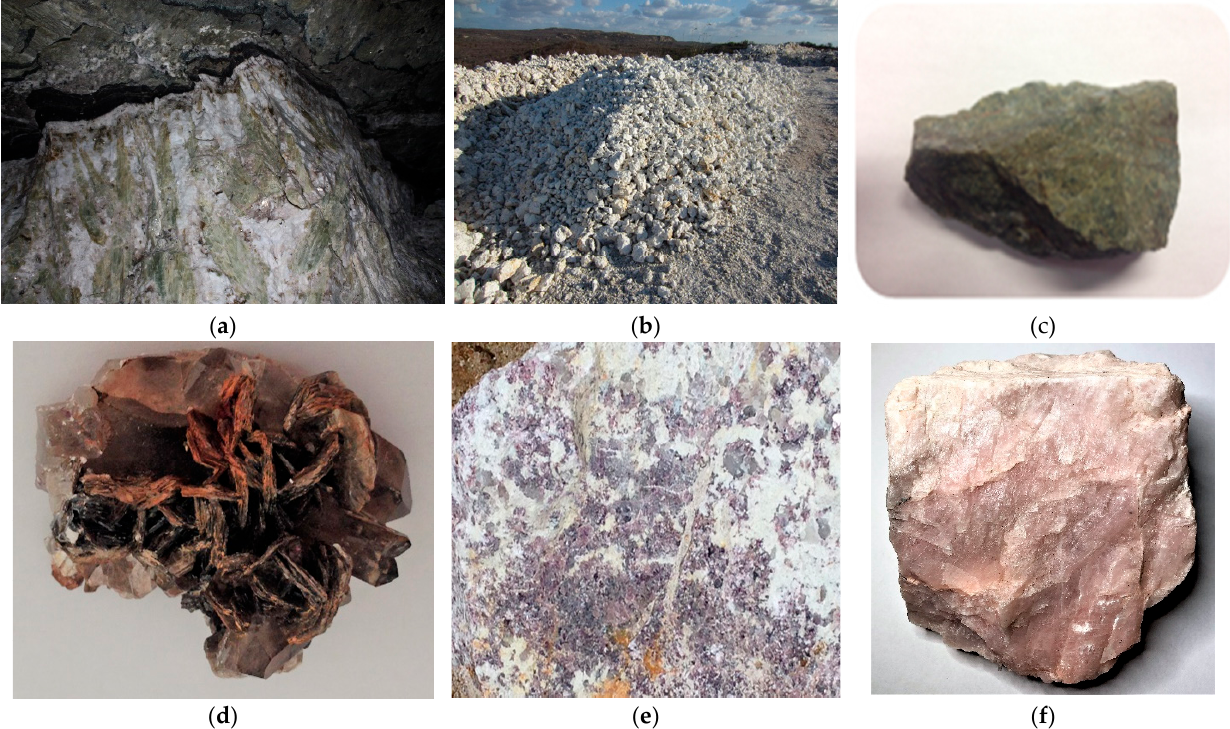
Figure 2. ( a ) Underground image of slightly green spodumene crystals (green crystal size ca. 1 m) in quartz matrix—MG—Brazil, ( b ) Montebrasite/Amblygonite occurrence with quartz—Serra Branca, Brazil, image: 30 m, ( c ) Triphylite with small quartz intergrowth—Hagendorf, Germany, image: 10 cm, ( d ) Zinnwaldite mica—Ore mountains/Germany, image: 5 cm, ( e ): Lepidolite in quartz/feldspar assemblage—Mangualde, Portugal, image: 10 cm, ( f ) Petalite/Rubicon mine–Namibia, image: 10 cm.